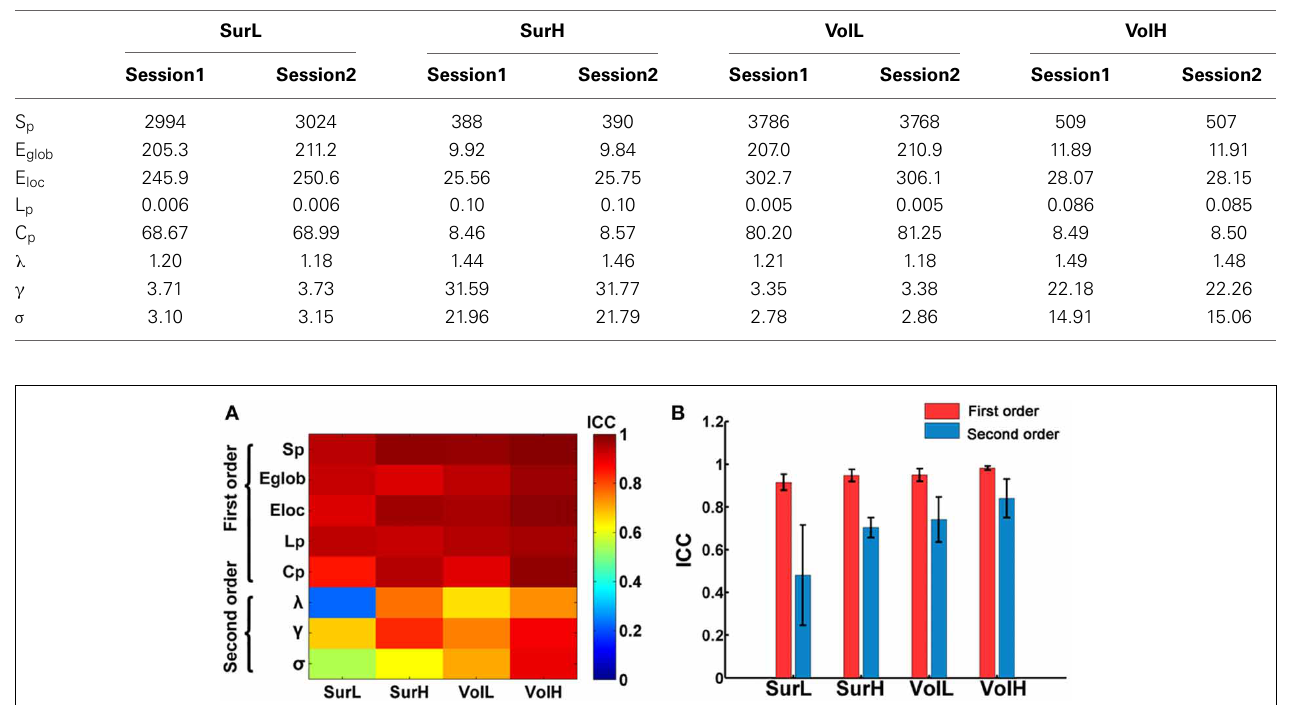
Table 3 | Global properties of WM network constructed from mEPI sequence.